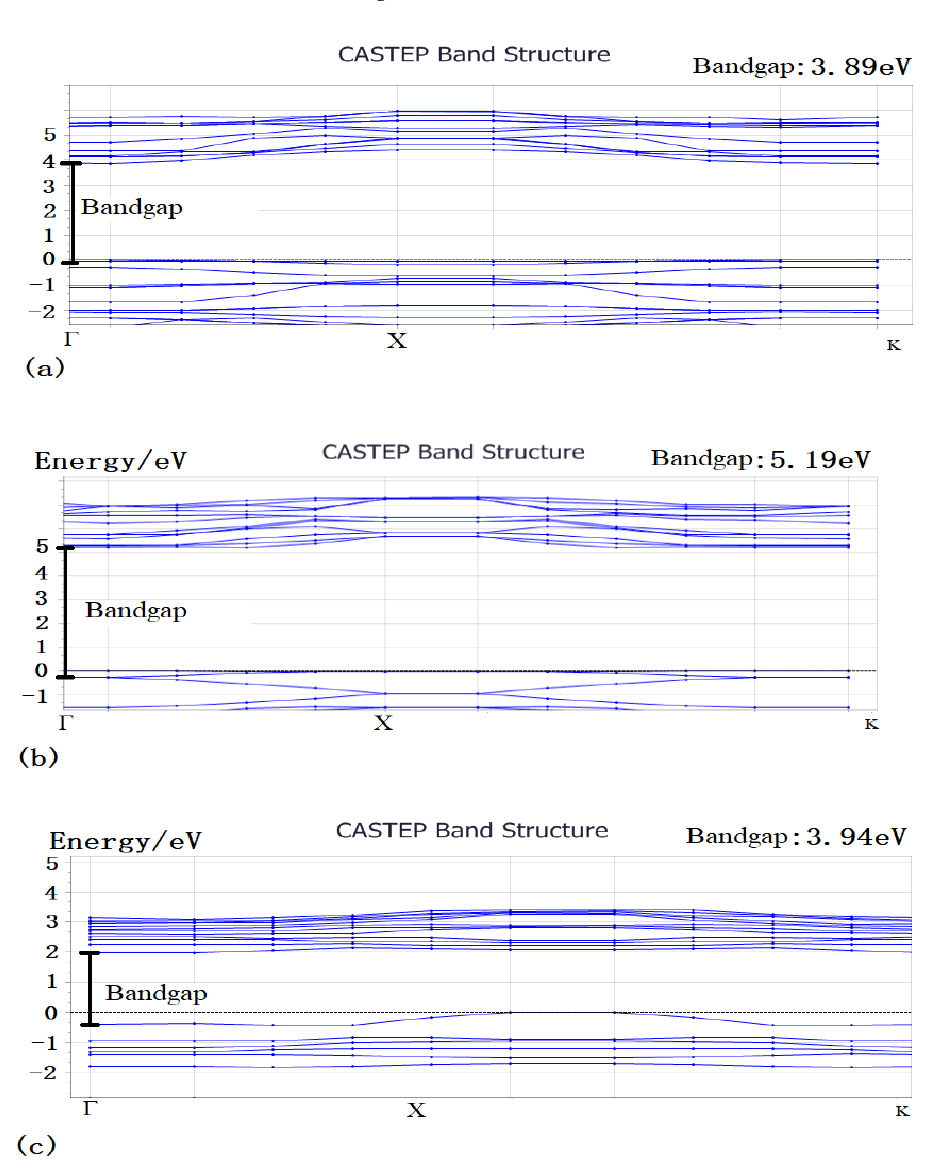
Figure 7. The energy band constructions respectively related to the top picture structure ( a ), the mid picture structure ( b ), and the bottom picture structure ( c ) in Figure 6.